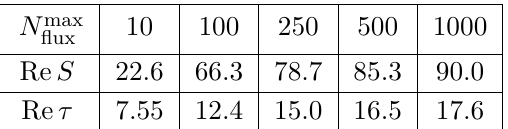
Table 12 . Probabilities of the stable vacua as functions of (Re (cid:28); Re S ) in the descending order of the probability for N max = 1000. (cid:13)ux